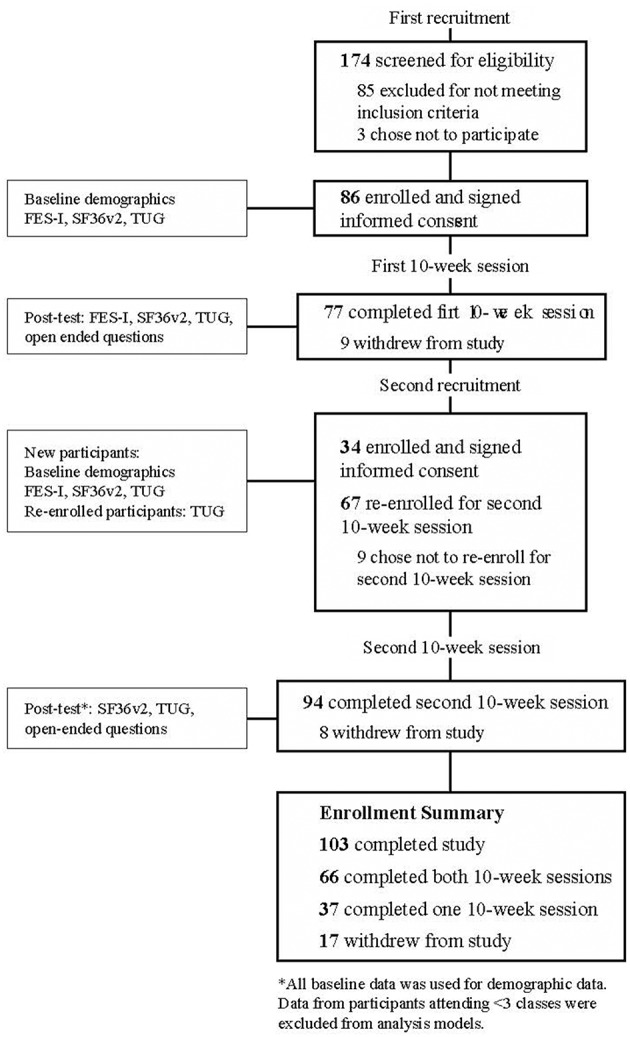
Enrollment flow and data collection sequence.